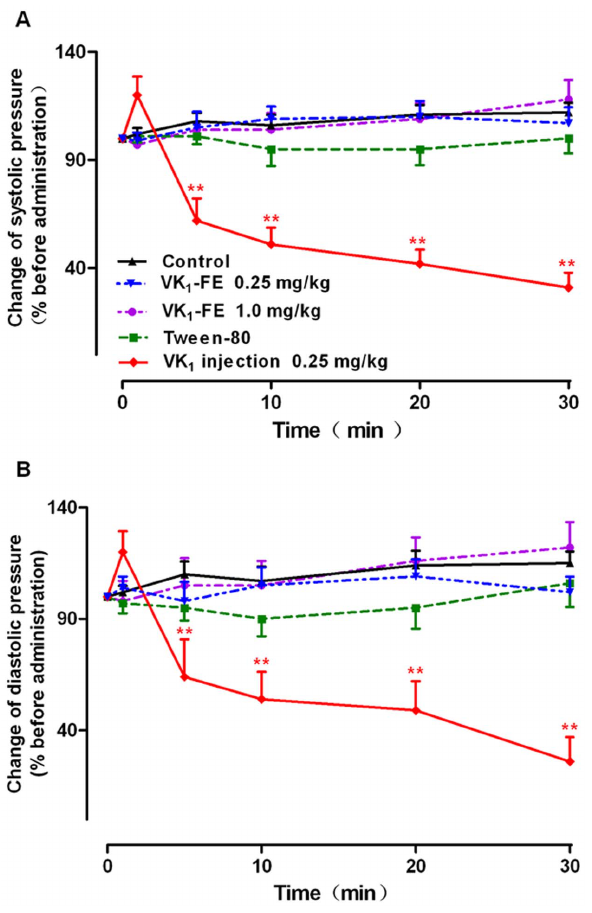
Figure 1. Effect of vitamin K 1 (VK 1 ) injection on systolic blood pressure (A) and diastolic blood pressure (B) in Beagle dogs. The change in blood pressure is presented as the decrease in blood pressure from before to after drug administration. The values are shown as the mean 6 SE, n=6. * P , 0.05, ** P , 0.01 vs. control. VK 1 -FE: vitamin K 1 -fat emulsion.